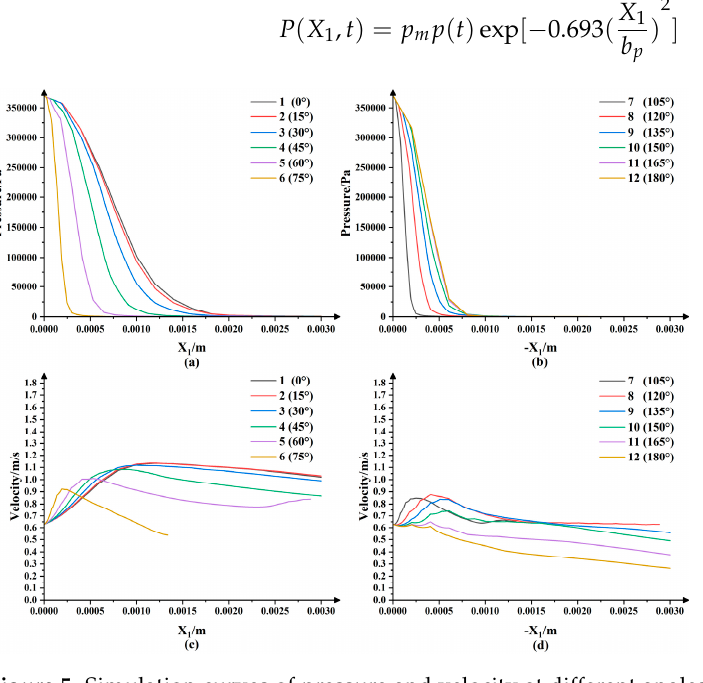
Figure 5. Simulation curves of pressure and velocity at different angles on the workpiece surface: ( a ) pressure curves at 0°~75°; ( b ) pressure curves at 105°~180°; ( c ) velocity curves at 0°~75°; ( d ) velocity curves at 105°~180°.